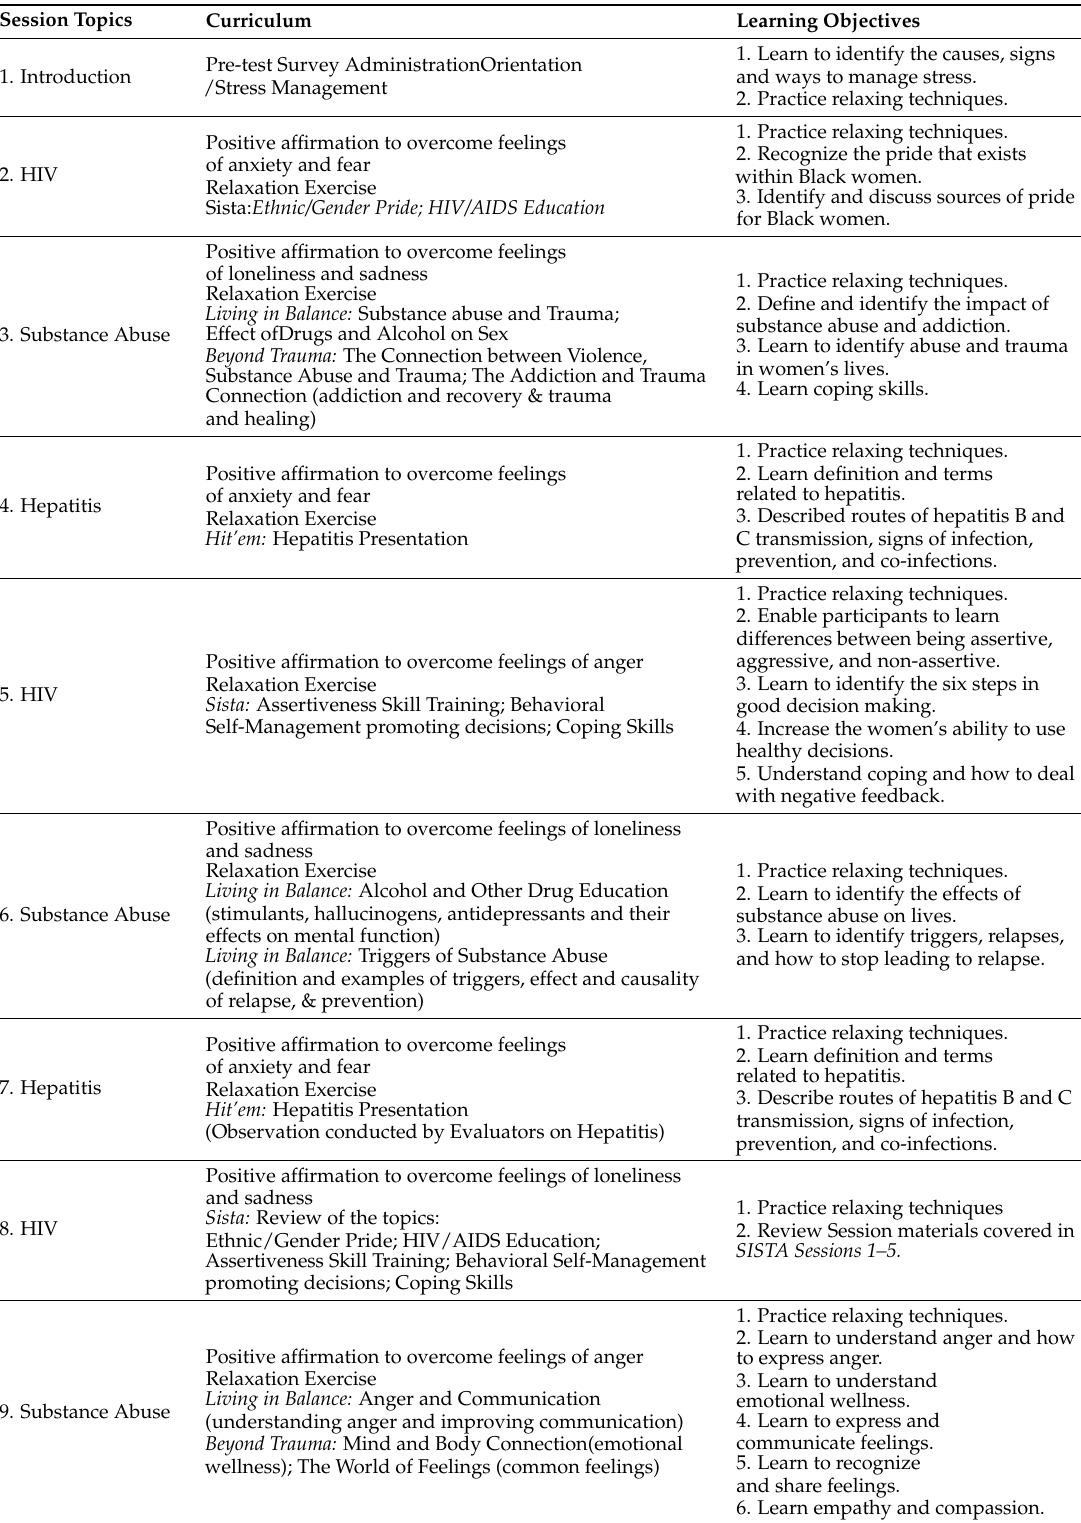
Table 1. Health, enlightenment, awareness, living (HEAL) intervention curriculum key